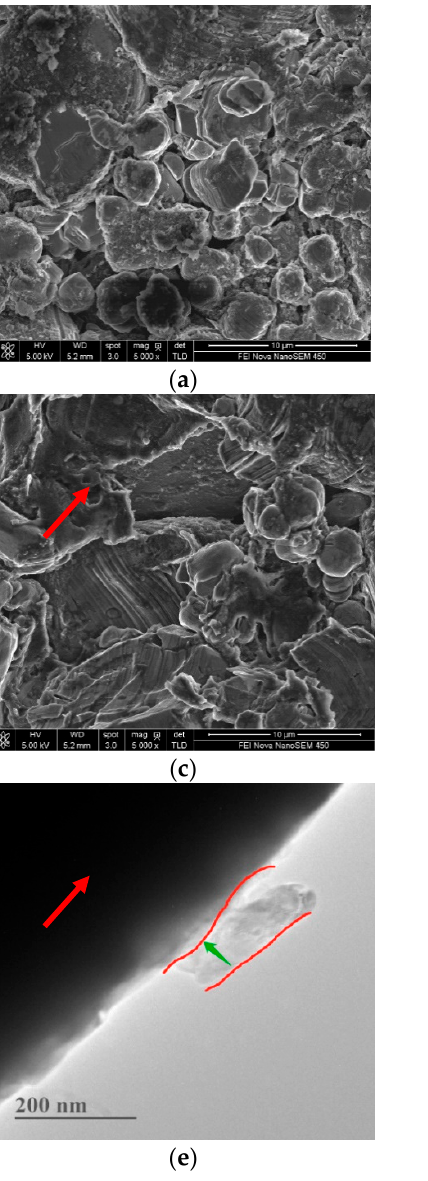
Figure 12. Morphological changes of electrode materials on cathodes with different electrolytes before and after cycle tests: ( a ) SEM image in #5 EL before cycling; ( b ) SEM image in #8 EL before cycling (the red arrow indicates the obvious cracks presented on the LiCoO 2 particles in the base electrolyte without additive DDDT); ( c ) SEM image in #5 EL after cycling; ( d ) SEM image in #8 EL after cycling; ( e ) TEM image in #5 EL before cycling (nanoscale SEI layer was formed); ( f ) TEM image in #8 EL before cycling (the SEI layer formed was thicker than that in #5 EL).